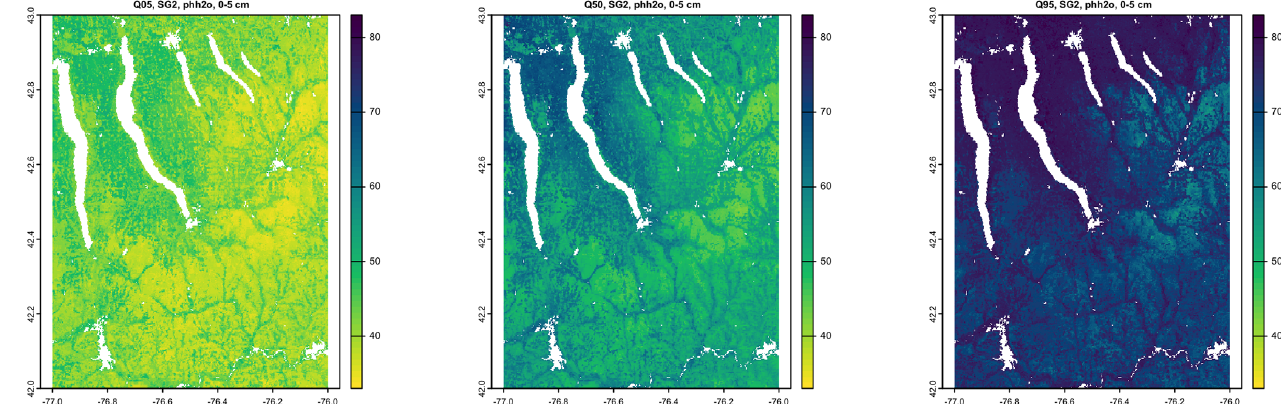
Figure 9. Quantiles of the prediction, SG2, for pH × 10 at 0–5cm. Note the unrealistically wide range at all locations and consistent patterning among quantiles.